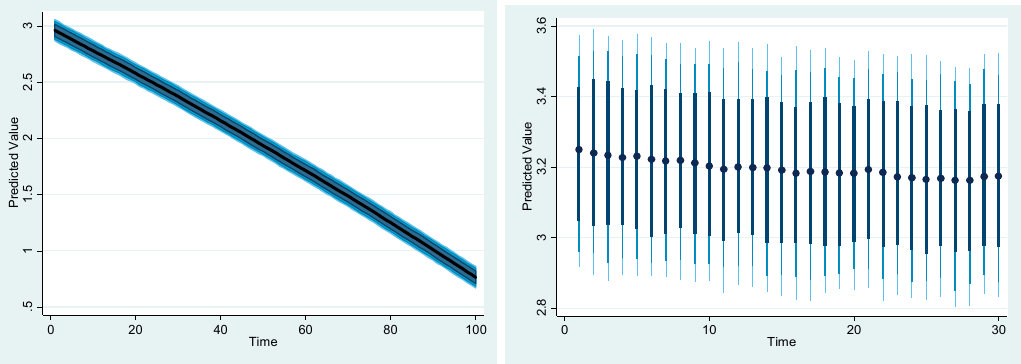
Figure A2. ln_renewln_domln_biocapacity.